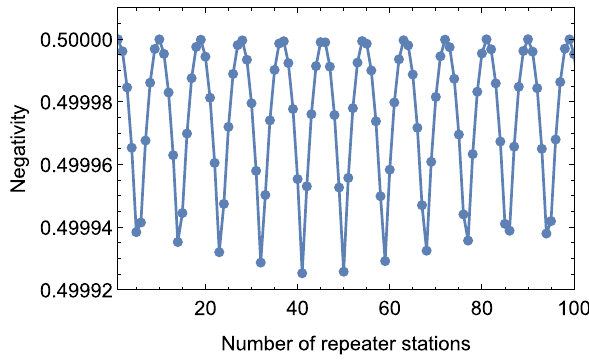
Figure 5. Negativity of the obtained state after ES over a hundred repeater stations.